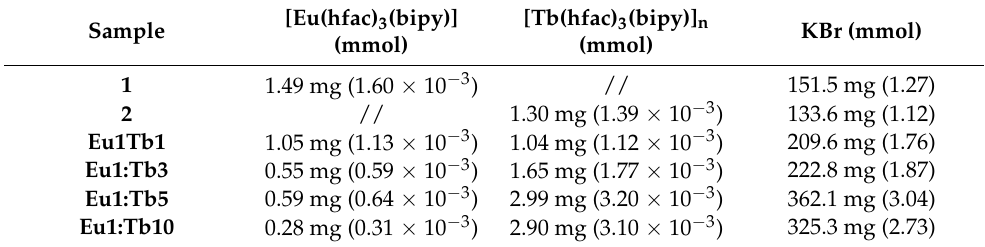
Table 1. [Eu(hfac) 3 (bipy)] n ( 1 ) and [Tb(hfac) 3 (bipy)] n ( 2 ) amounts dispersed in KBr in the differ- ent samples.